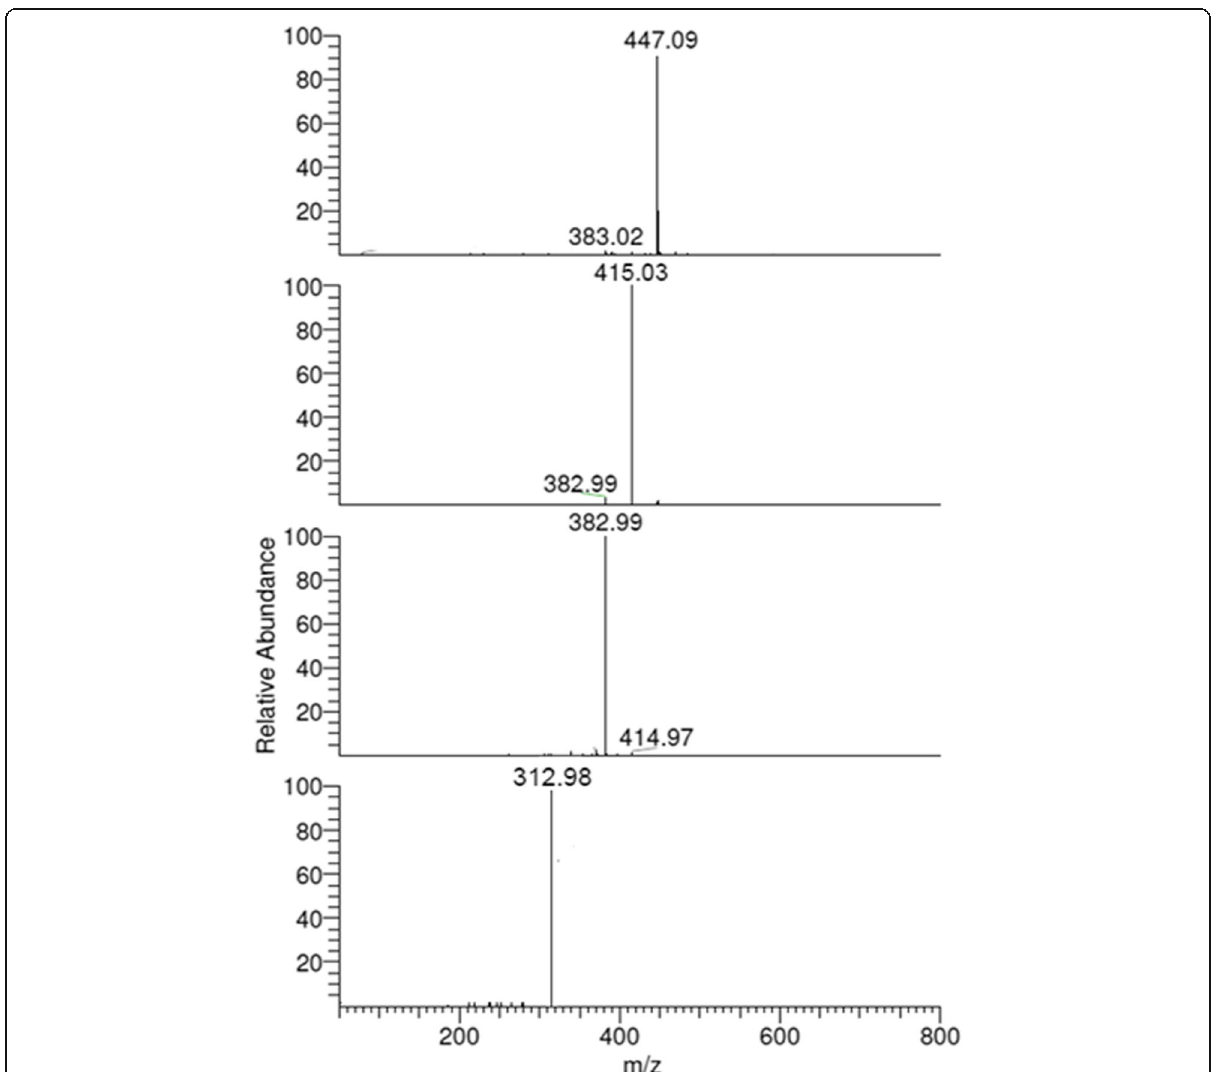
Fig. 4 Mass spectrum of febantel obtained during LC-MS/MS